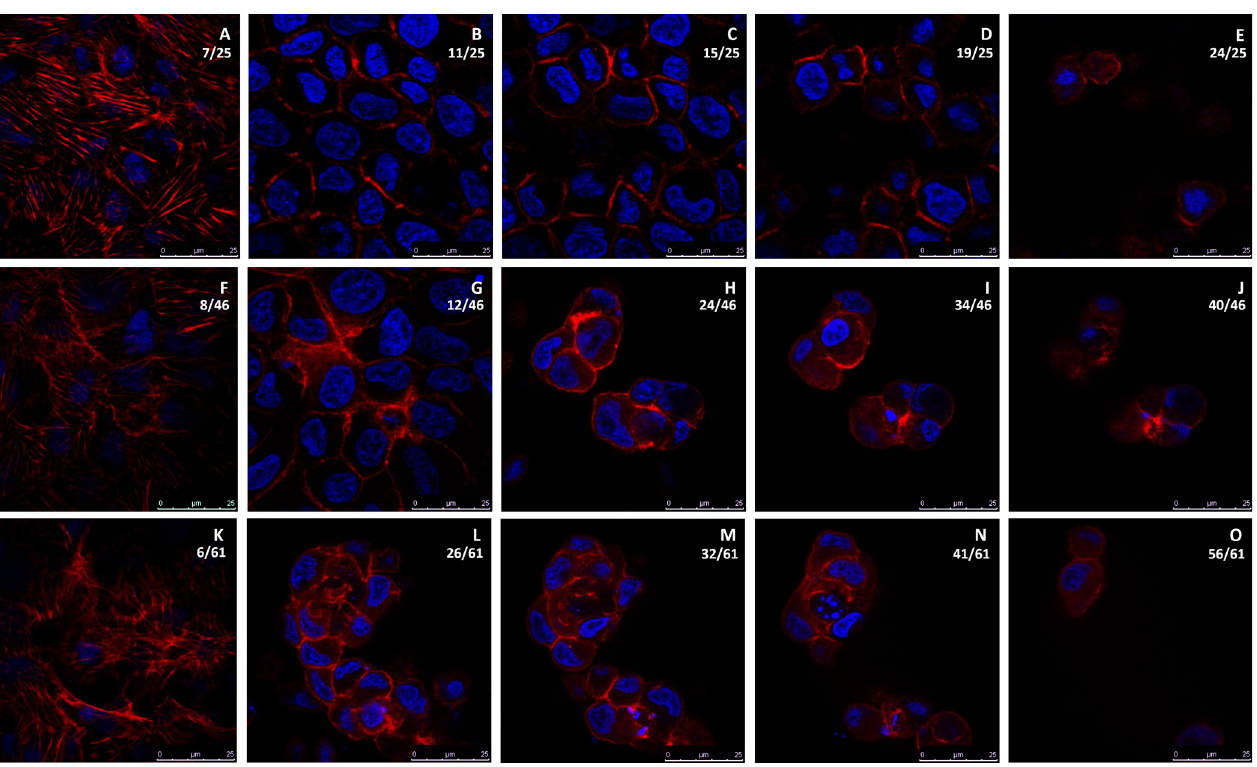
Fig 4. Intracellular localization of F-actin in a doming population of HK-2(MT-3) cells. F-actin (red) is seen in a non-doming monolayer (A-E), a moderately tall dome (F-J), and in a taller dome structure (K-O). Nuclei are stained with DAPI (blue). The z-section level (0.35 μ m depth) relative to the total number of z-sections through that region are indicated as a ratio in the upper right corner of each image. The scale bar at the bottom right of each image shows increments of 5 μ m up to 25 μ m.